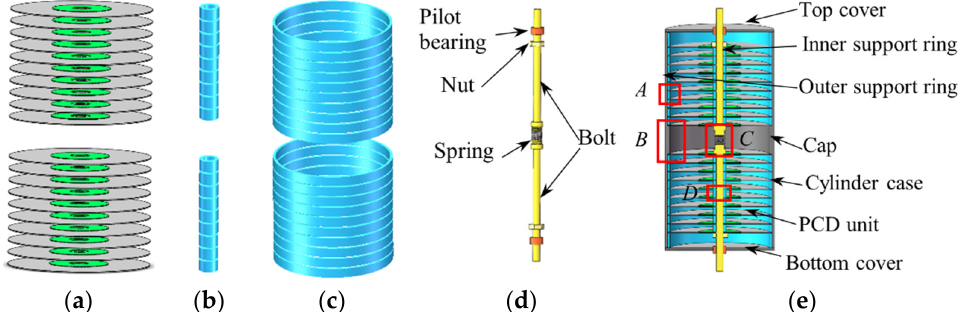
Figure 2. Set-up of a piezoelectric damper. ( a ) PCD array; ( b ) inner support ring array; ( c ) outer support ring array; ( d ) load transfer unit; ( e ) section view of piezoelectric damper.